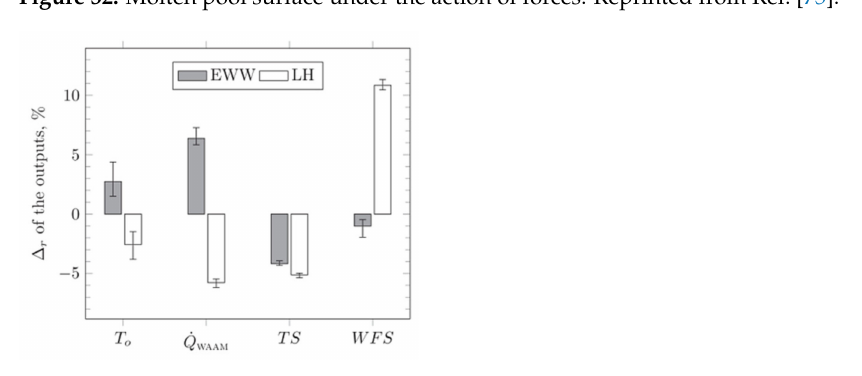
Figure 33. Effect of process parameters on deposit dimensions. Reprinted from Ref.